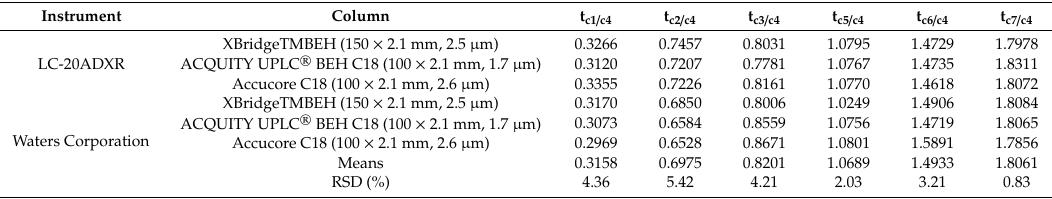
Table 9. The relative retention time of seven